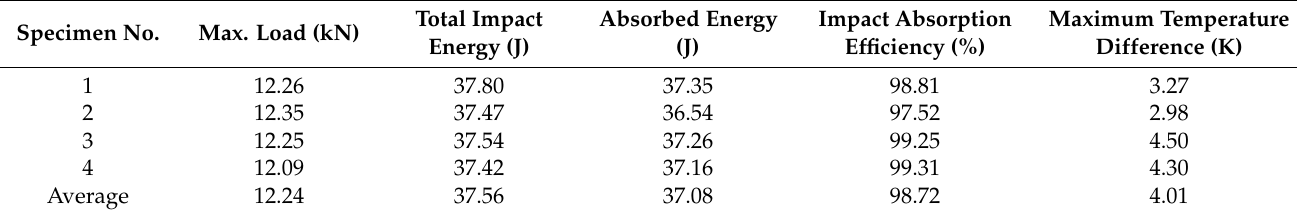
Table 4. Impact test results for specimens laminated in 0 ◦ /90 ◦